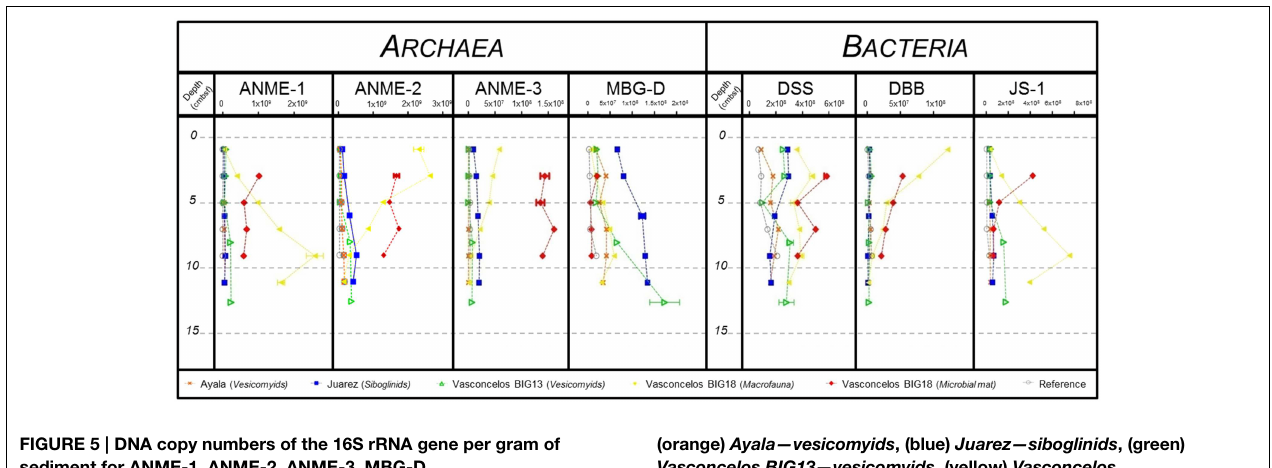
(orange) Ayala—vesicomyids , (blue) Juarez—siboglinids , (green) Vasconcelos BIG13—vesicomyids , (yellow) Vasconcelos BIG18—macrofauna and (red) Vasconcelos BIG18—white mat sites in function of depth in cold seep sediments of the Sonora